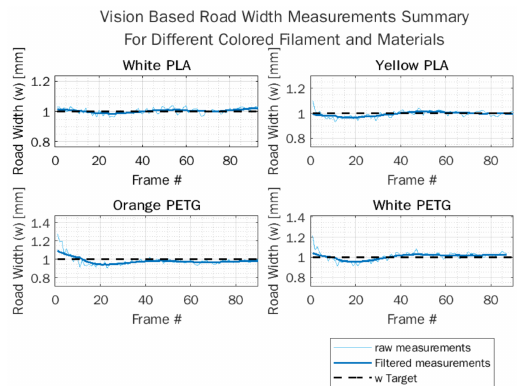
Figure A1. Summary of vision-based extrusion width measurements for different colored filaments and